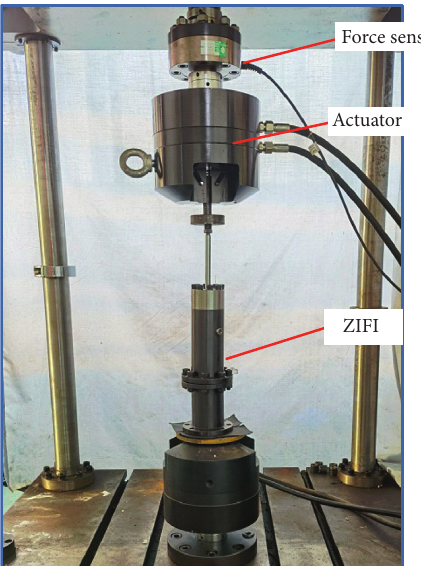
Figure 5: Quasistatic loading